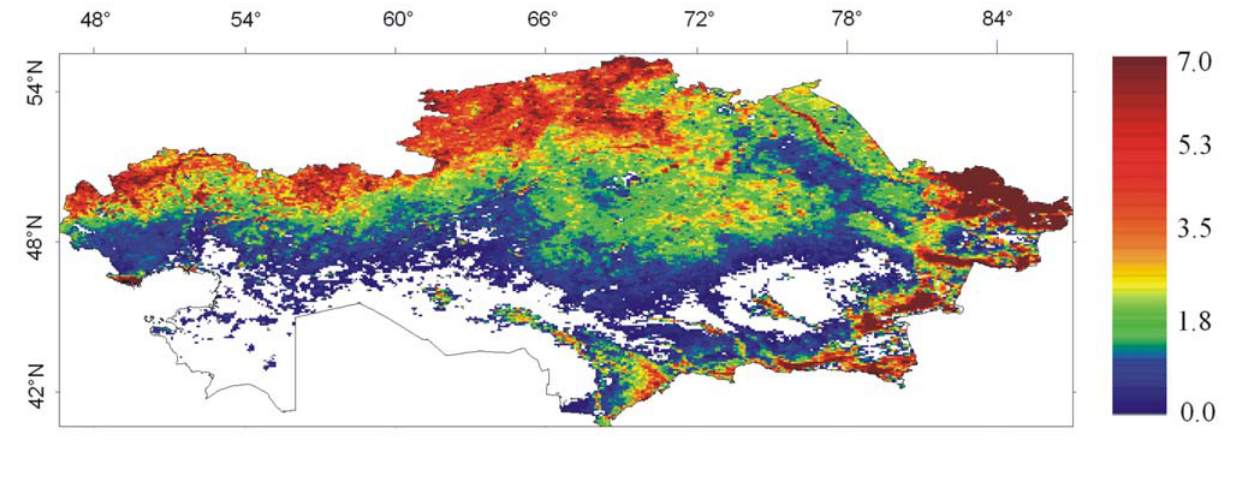
Figure 2. Distribution of the AVHRR LAI for June 2008 over the Republic of Kazakhstan.